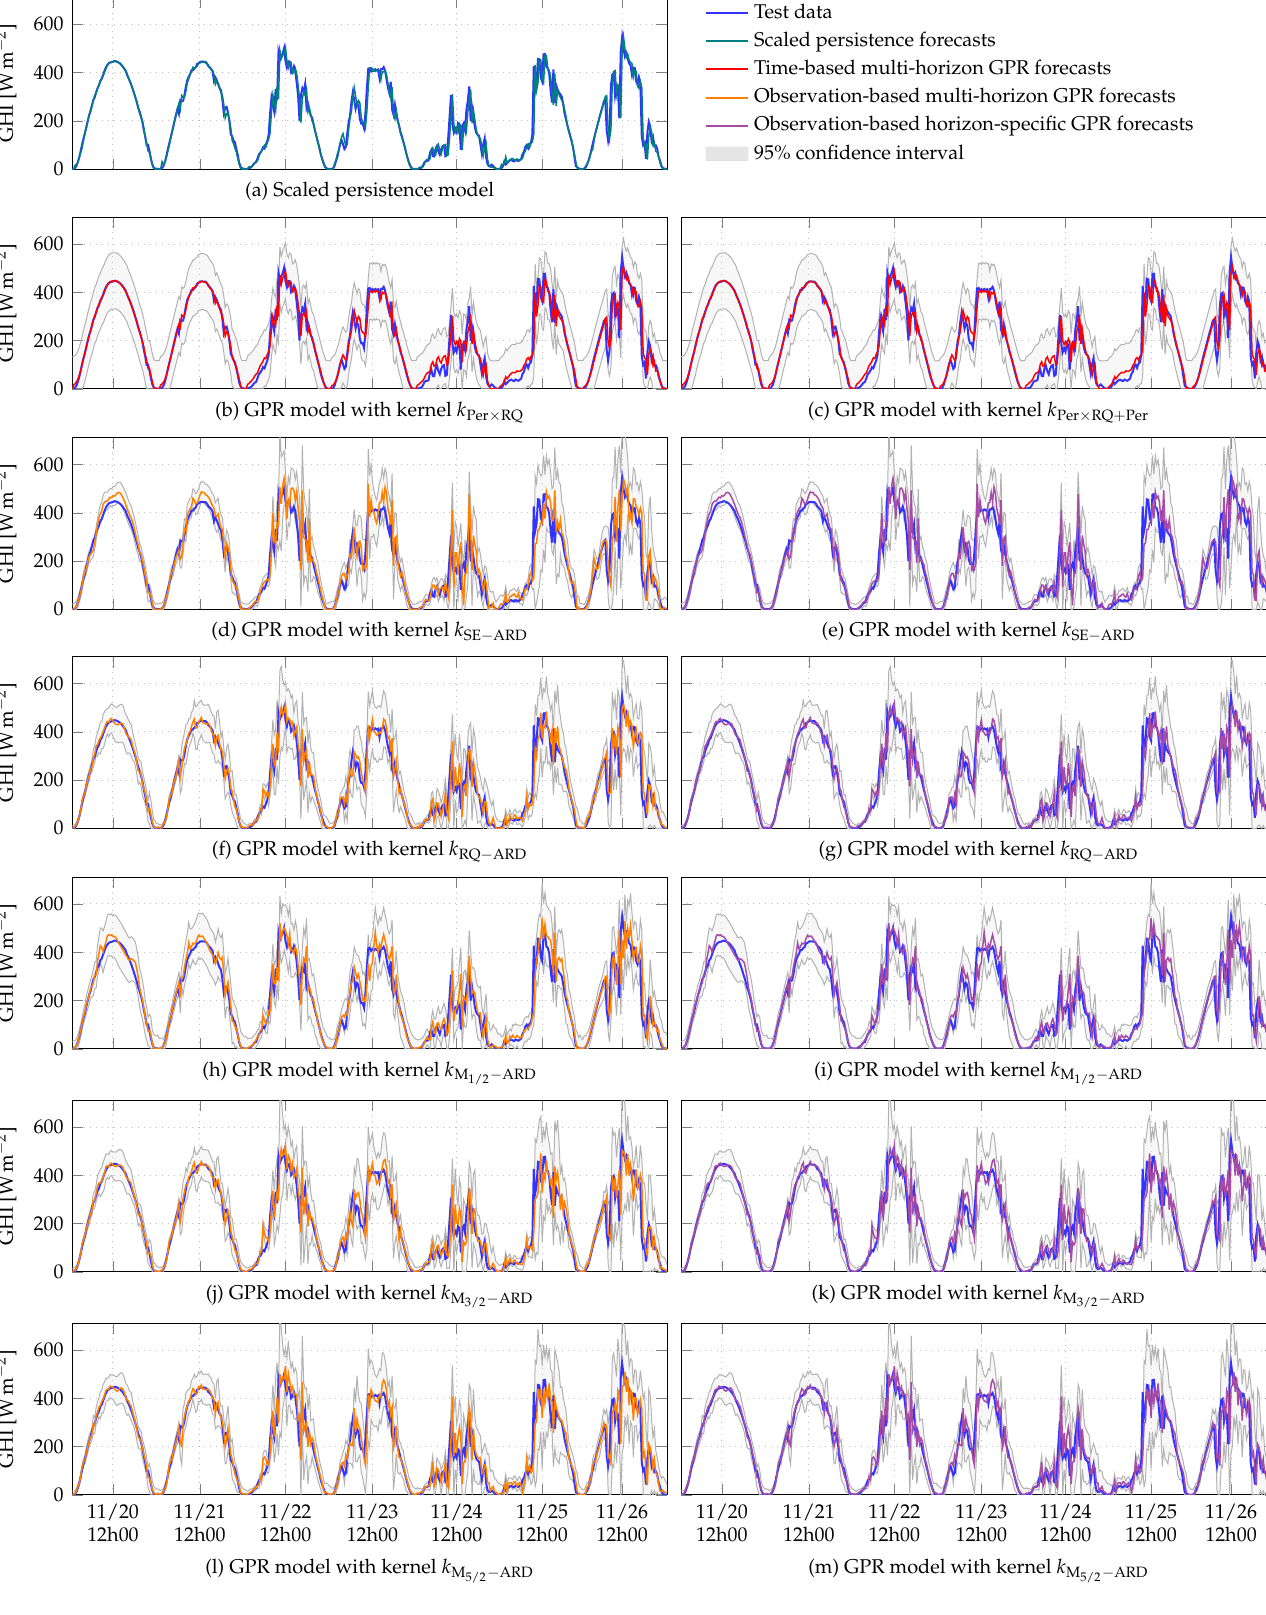
Figure 11. Examples of 10 min GHI forecasts over one week, given by the scaled persistence model and the GPR models included in this